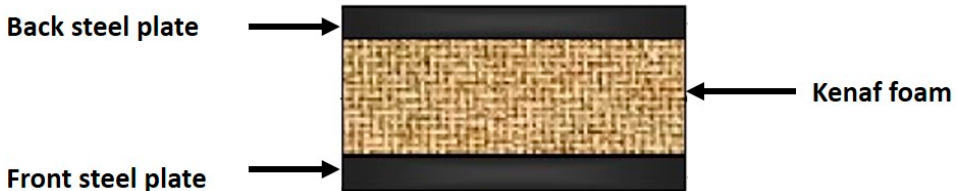
Figure 12. Cross sectional of sandwich armor plate with kenaf foam.